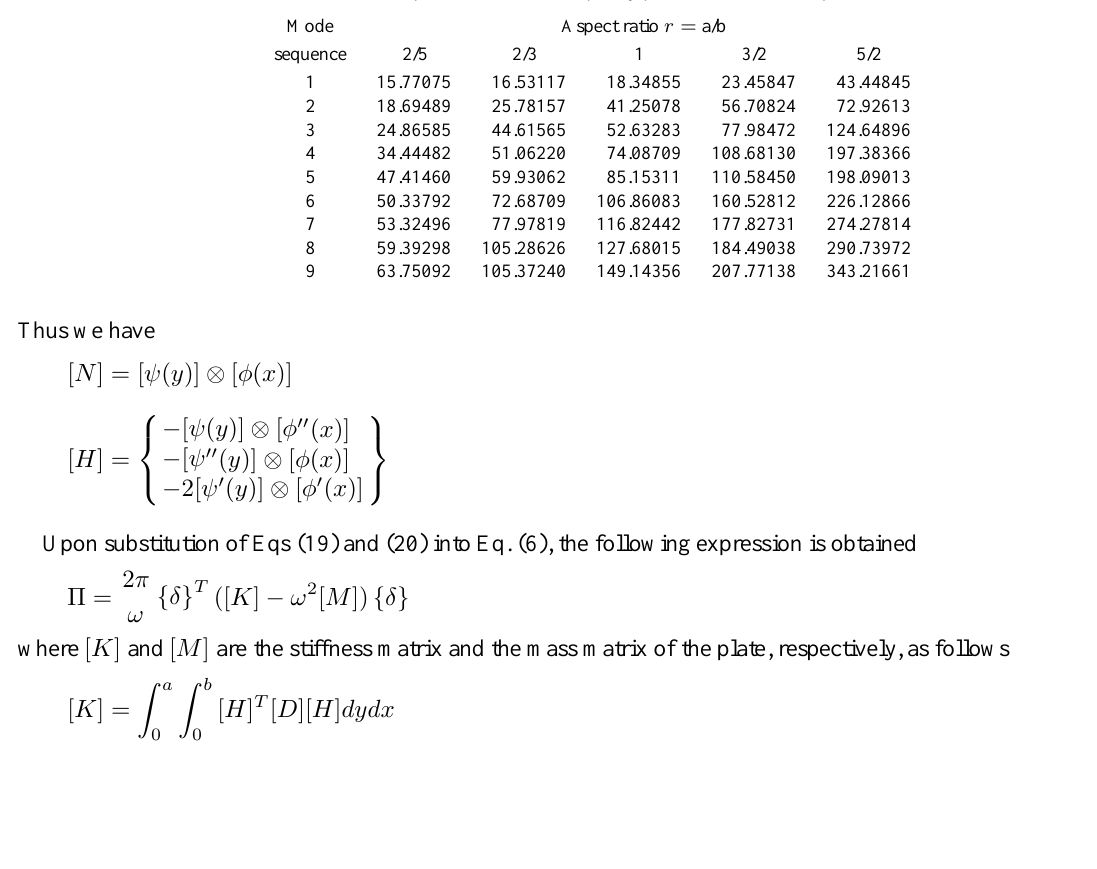
Table 6 Bicubic B-spline solutions of frequency parameters for CCSG